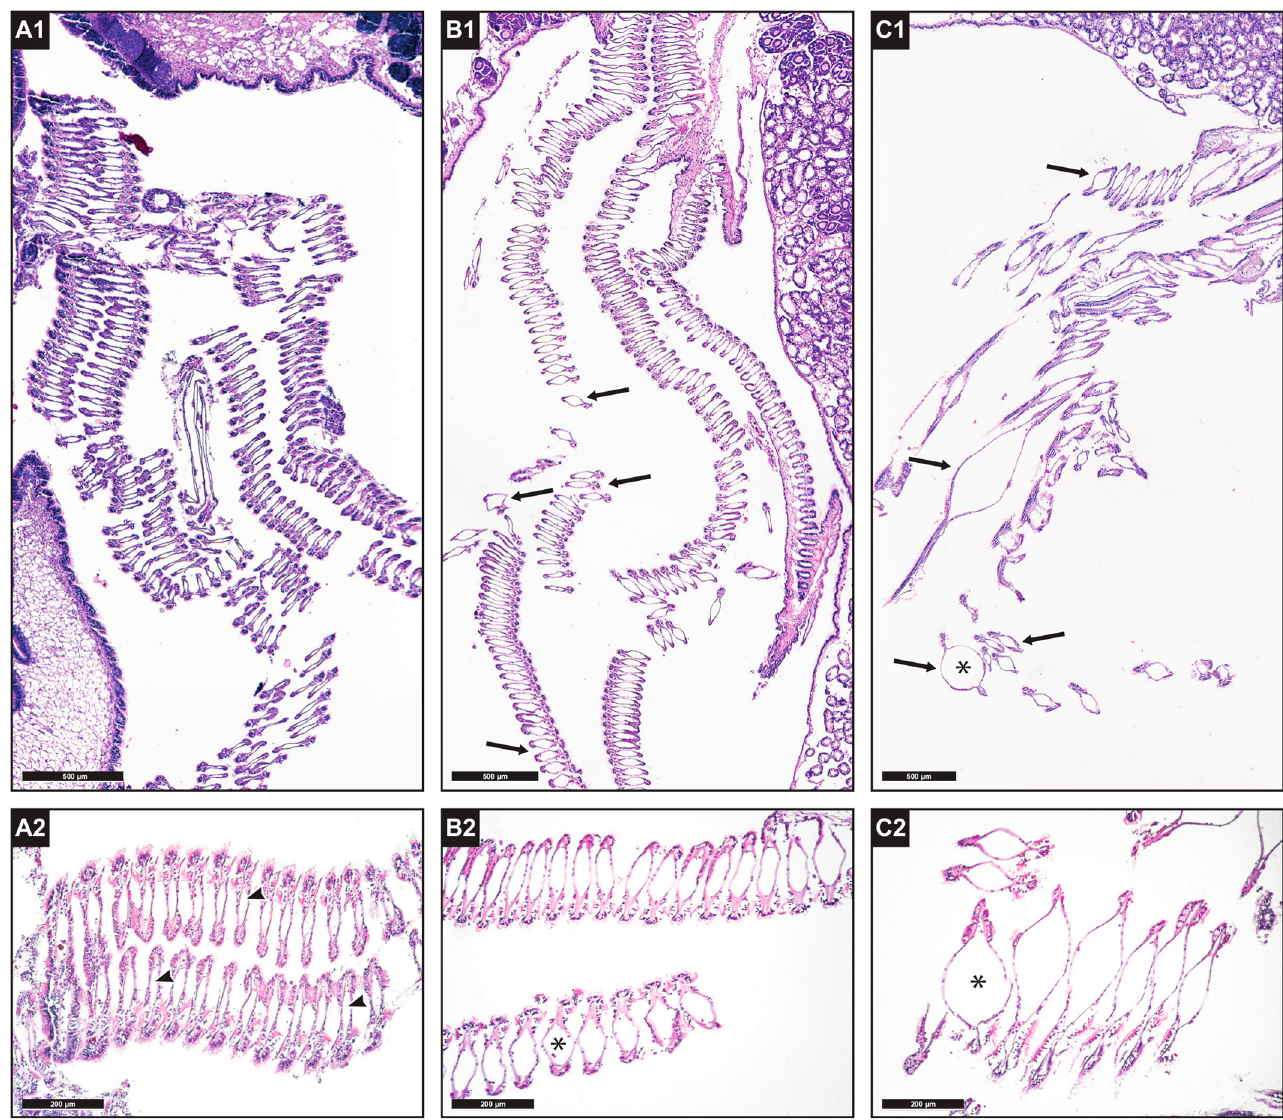
Figure 7. ( A1 ): Gill ctenidial laminae from the control group, showing homogenous gill filament structure with hemolymphatic spaces of normal size (4×). ( A2 ): detail of normal gill filaments from control (group 1–2) (10), hemolymphatic spaces appear normal (arrowheads). ( B1 ): ctenidial laminae from the ndl-PCBs-treated group (4×), moderate dilatation of hemolymphatic spaces (arrows). ( B2 ): detail of gill filaments from the ndl-PCBs-treated specimens (group 3–4) with moderate dilatation of the hemolymphatic spaces (*) (10×). ( C1 ): ctenidial laminae of TiO 2 NPs and ndl-PCBs -treated group (4 × ), severe dilatation of the hemolymphatic spaces (arrows). ( C2 ): detail of gill filaments of TiO 2 NPs and ndl-PCBs-treated specimen (group 5–6) with strongly dilated (*) hemolymphatic space (10 ×